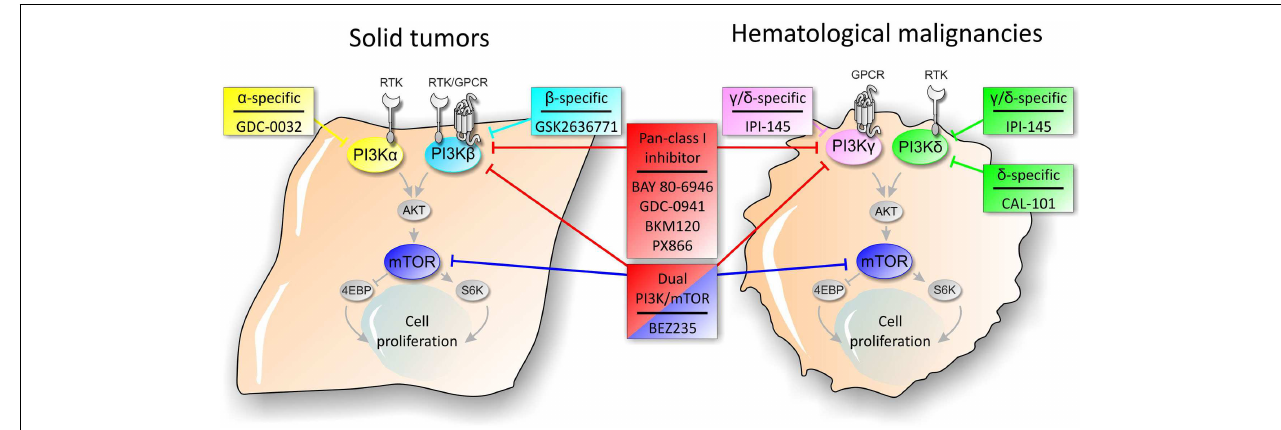
FIGURE 1 | Schematic representation of PI3K pathway and sites of action of PI3K signaling pathway inhibitors in solid tumors and hematological malignancies .